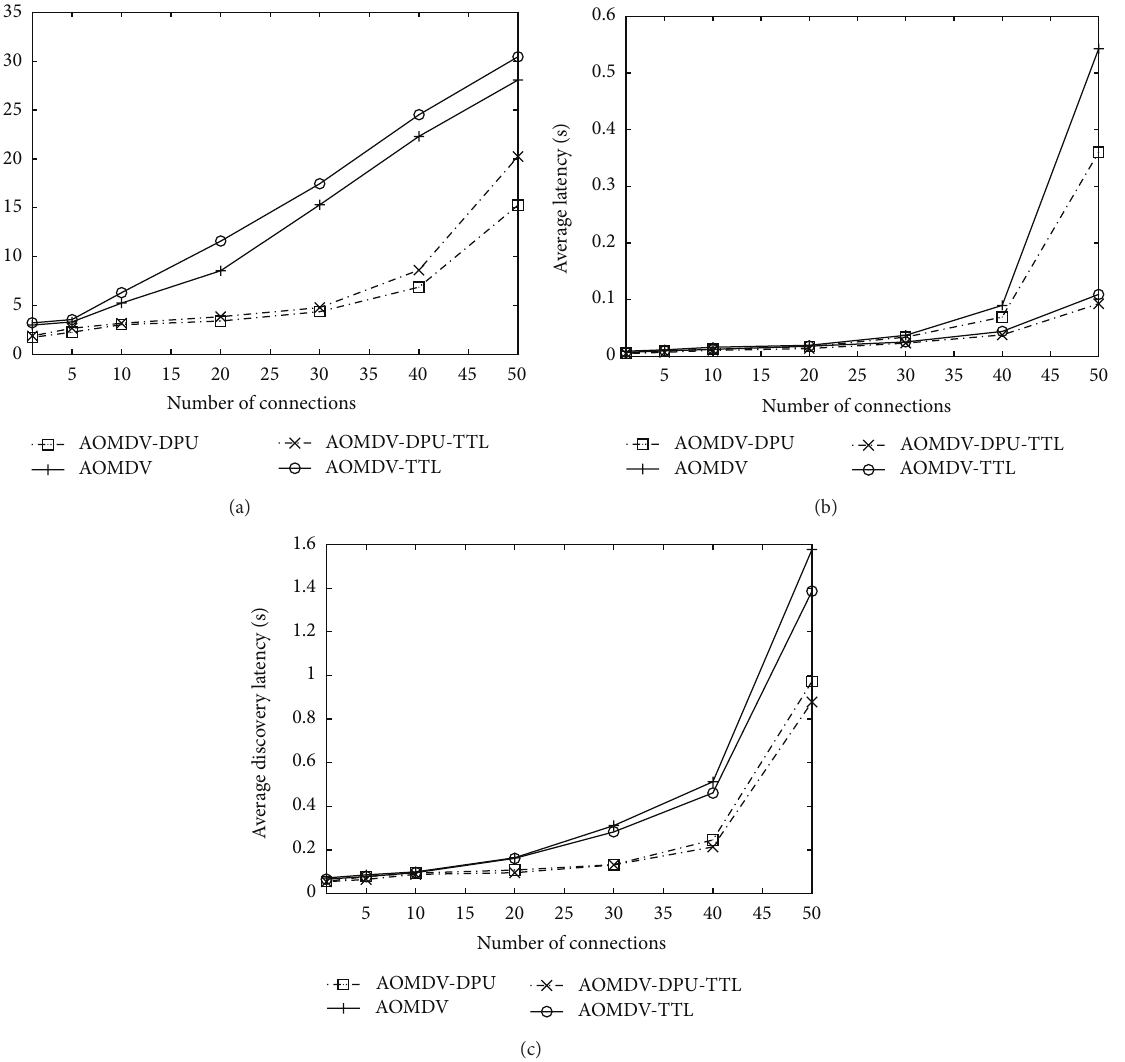
Figure 6: Performance with varying number of connections (a) packet loss, (b) average packet delivery latency, and (c) route discovery